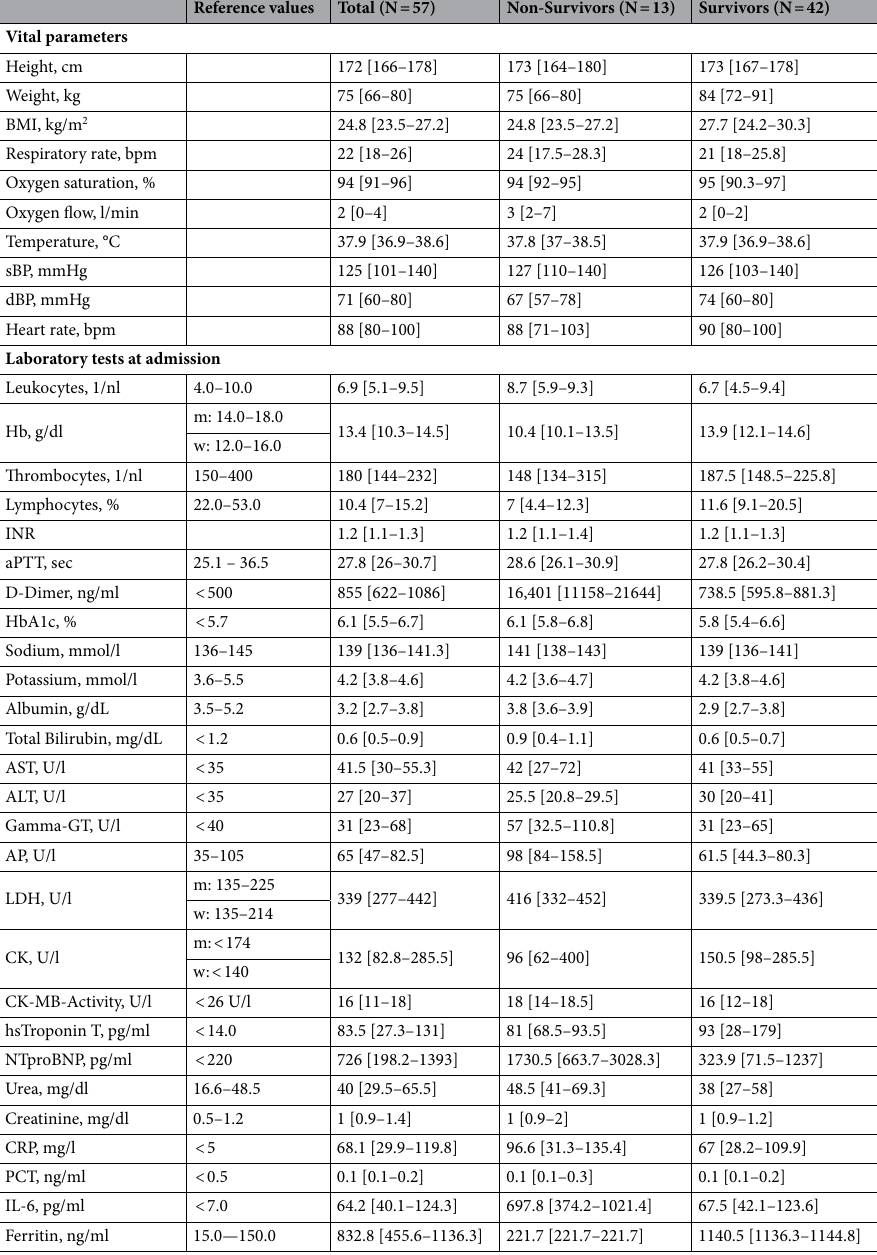
Table 3. Vital and laboratory parameters. Data in Median [IQR] IQR, interquartile range; BMI, body mass index; sBP, systolic blood pressure, dBP, diastolic blood pressure; Hb, hemoglobin; INR, international normalized ratio; aPTT, activated partial thromboplastin time; AST, aspartate aminotransferase; ALT, alanine aminotransferase; Gamma-GT, gamma-glutamyltranspeptidase; AP, alkaline phosphatase; LDH, lactate dehydrogenase; CK, creatine kinase; hs, high sensitive; NTproBNP, N-terminale pro brain natriuretic peptide; CRP, C-reactive protein; PCT, procalcitonin; IL-6,